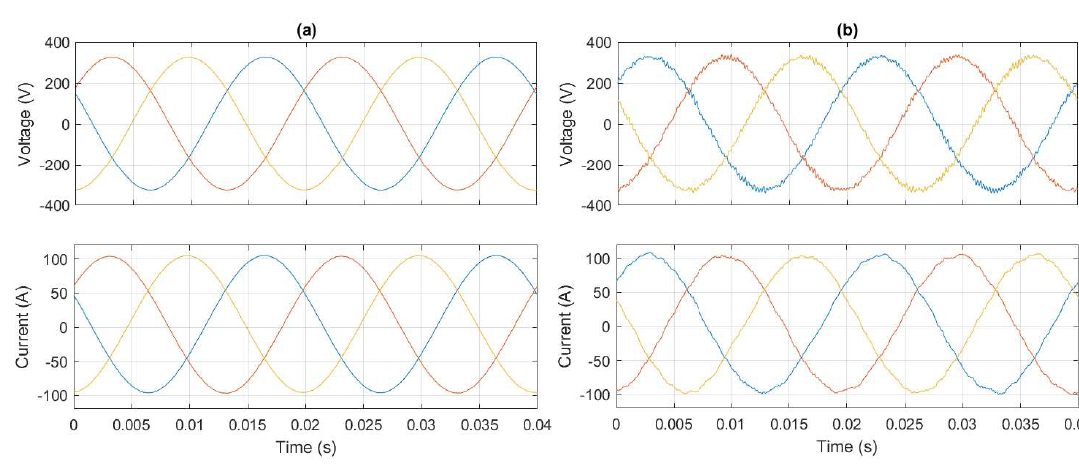
Figure 11. Waveforms at the grid interface ( a ) without and ( b ) with the MIMO injection signal added to converter G4 output current